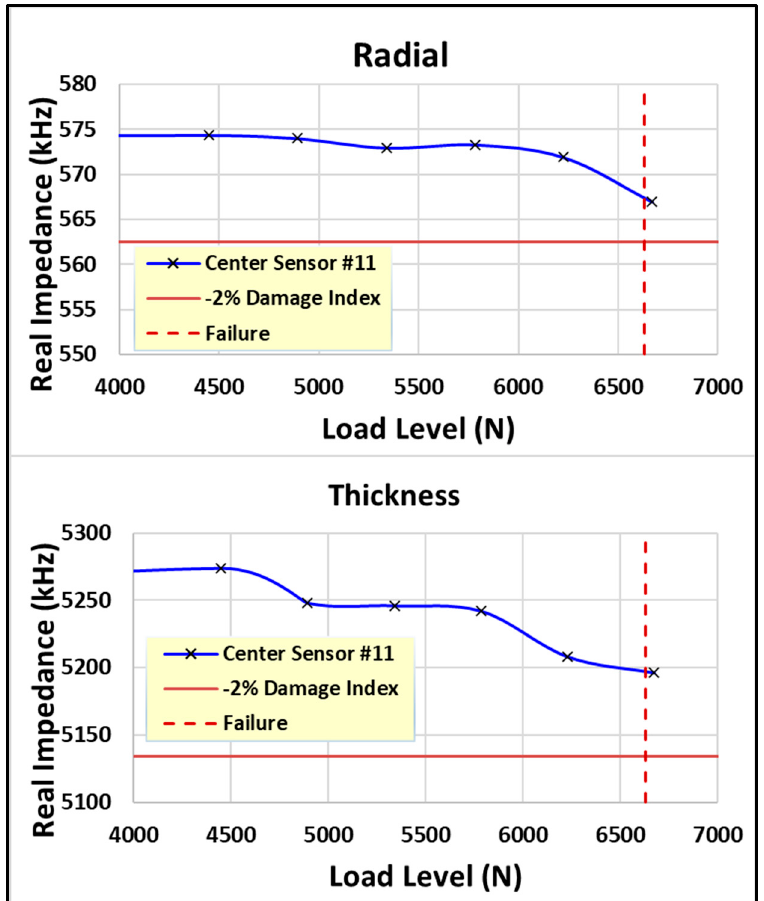
Figure 27. Sensor #11 real impedance versus load level.